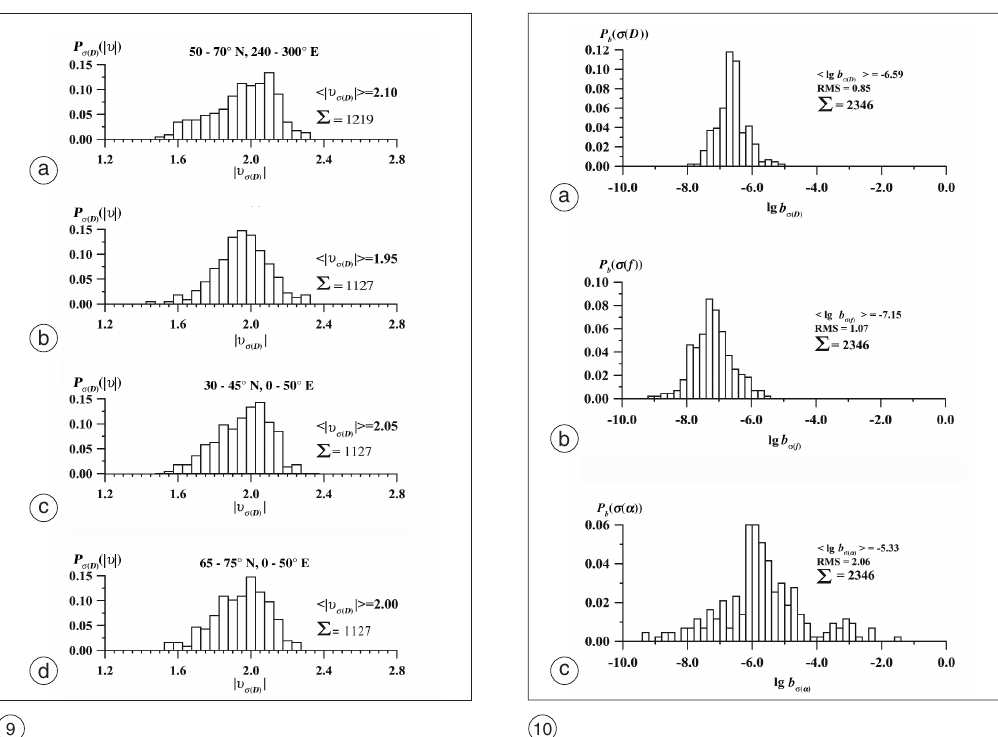
Fig. 9a-d. Probability distributions means values of the slopes of power law spectra of the error σ ( D ). The ν σ ( D ) dependence for different levels of geomagnetic activity: panel (a) (magnetically quiet conditions) and panel (b) (magnetically disturbed conditions). The ν σ ( D ) dependence on latitude (magnetically disturbed conditions): pan- els (c) and (d). Mean values of the slopes ν σ ( D ) , and also total numbers of the values of the slopes of the corre- sponding spectra use in the analysis are shown in all panels. Fig. 10a-c. Probability distributions (a) P b ( σ ( D )), (b) P b ( σ ( f )) and (c) P b ( σ ( α )) of the scales lg b σ ( D ) , lg b σ ( f ) and lg b σ ( α ) of the power law spectra of the errors. Mean values of the slopes, (cid:1) lg b σ ( D ) (cid:2) , (cid:1) lg b σ ( f ) (cid:2) , (cid:1) lg b σ ( α ) (cid:2) (on a logarithmic scale), standard deviations, and also total numbers of the values of the scales of the corresponding spectra used in the analysis are shown in all